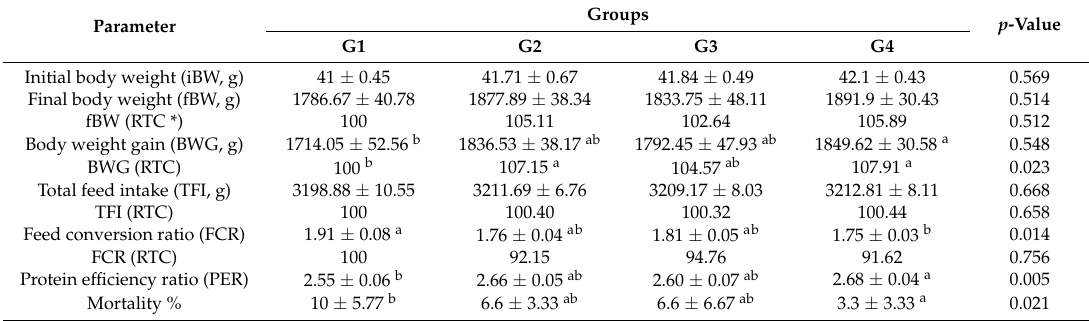
Table 2. Effect of dietary supplementation of Clostridium butyricum ( C. butyricum ) and Saccharomyces cerevisiae ( S. cerevisiae ) on the growth indices of broiler chickens.